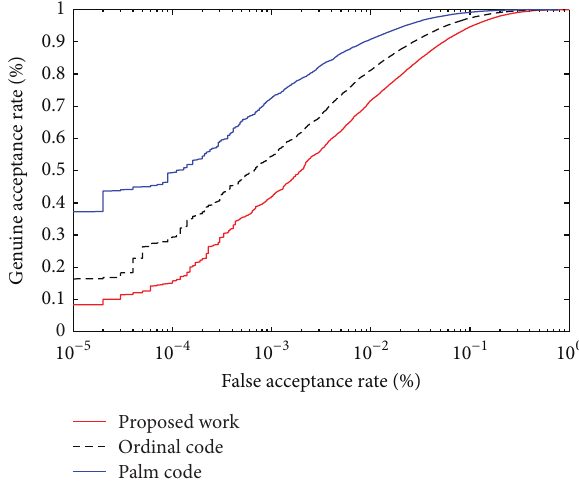
Figure 15: ROC curve using local features of proposed DOST for IIT Delhi palmprint database.